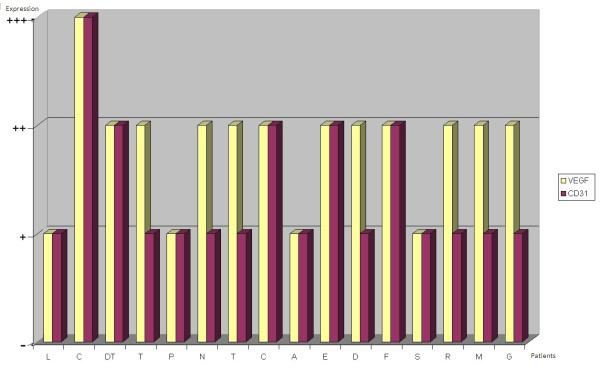
Bar charts showing levels of VEGF and CD31 expression in post-chemotherapy resection specimens.